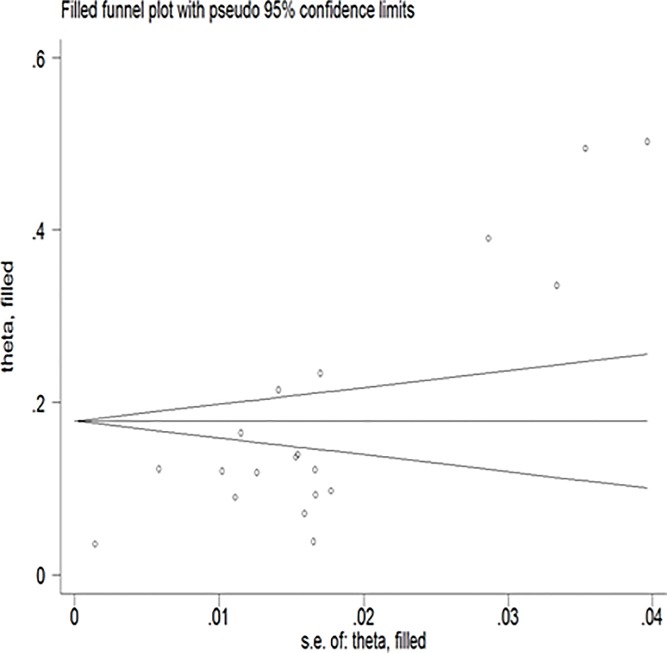
Filled funnel plot with pseudo 95% confidence interval.